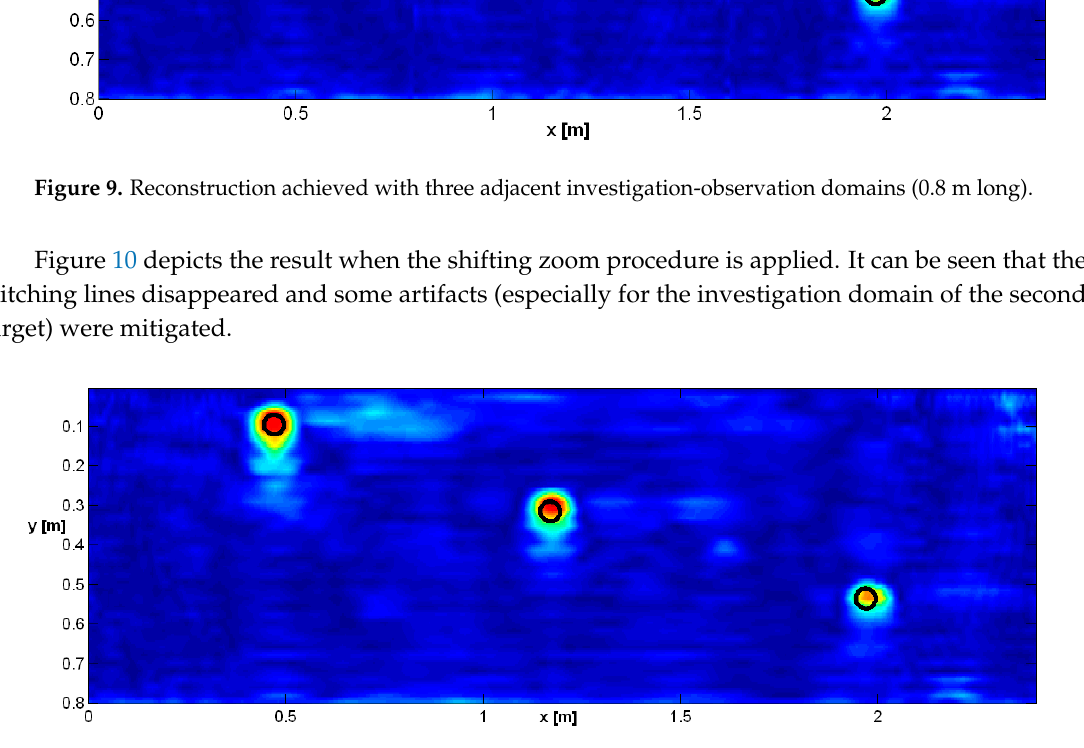
Figure 10. Reconstruction achieved with a shifting zoom. The shifting step is 1 cm, equal to the spatial step of the data, and to the horizontal size of the pixels, for the representation of the reconstruction.